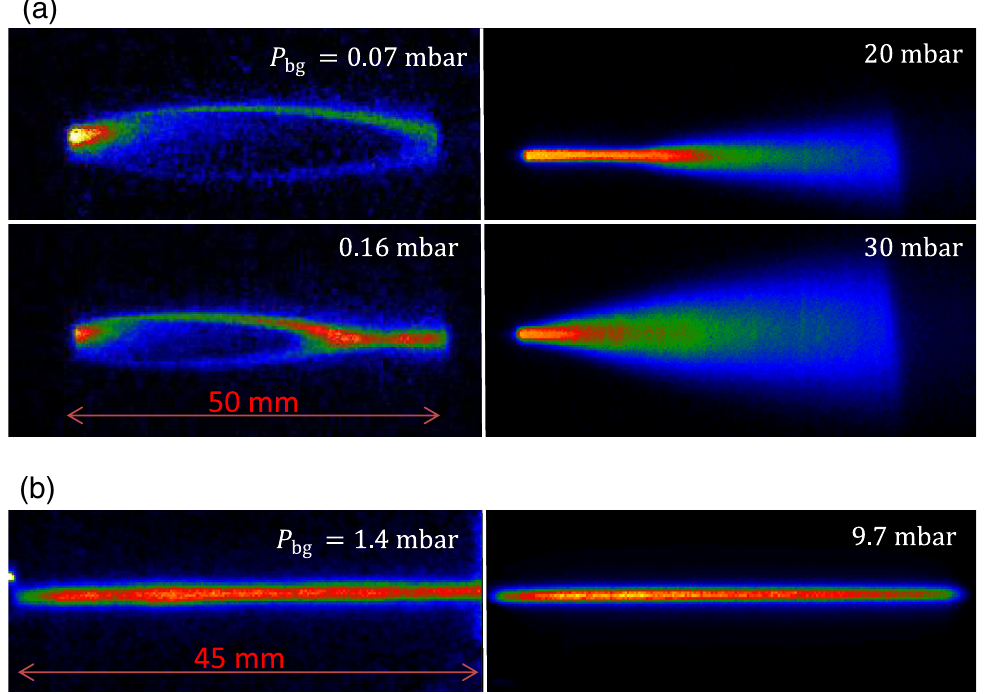
FIG. 11. Visualization of quasiuniform, over- and underexpanded jets. The color code indicates the intensity of the fluorescence signal in a similar way as in Fig. 7. (a) Under- and overexpanded jets formed by nozzle 1 are shown in the left-hand and right-hand panels, respectively, for P 0 ∼ 300 mbar. (b) Quasiuniform jets formed by nozzle 1 for a pressure P 0 ∼ 325 mbar (left-hand panel) and nozzle 2 for P 0 ∼ 340 mbar (right-hand panel) for adjusted pressures P inside the gas cell chamber. bg